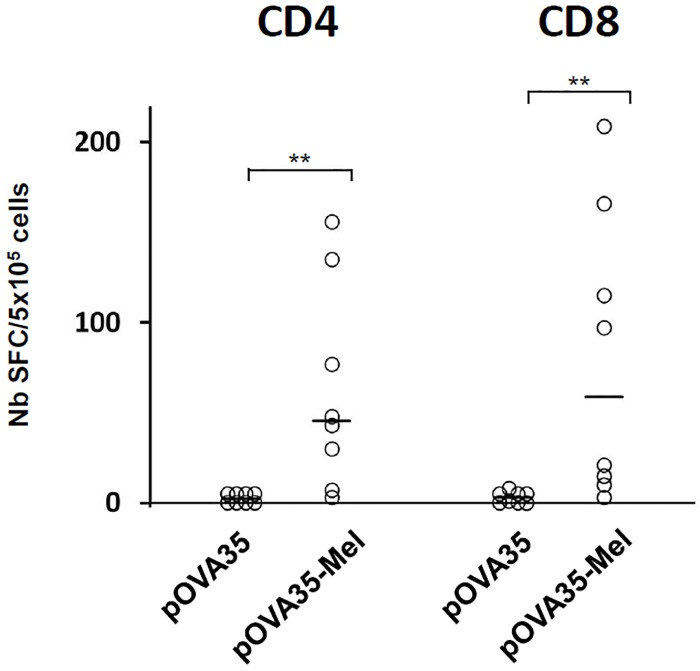
T-cell response after subcutaneous immunizations in C57BL/6 mice.Mice were immunized with pOVA35 or pOVA35-melanin (pOVA35-Mel), on days 0 and 14 and sacrificed on day 21. Splenocytes were re-stimulated in vitro either with a) the MHC class II epitope (CD4) or b) the MHC class I-epitope (CD8) (non conjugated to melanin). The numbers of IFNg-SFCs (Spot forming cells) were measured. Each point represents an individual mouse (n = 8 mice/group with pooled data from 2 different experiments of 4 mice each). Bars = median. ** p < 0.01 (Mann–Whitney test).